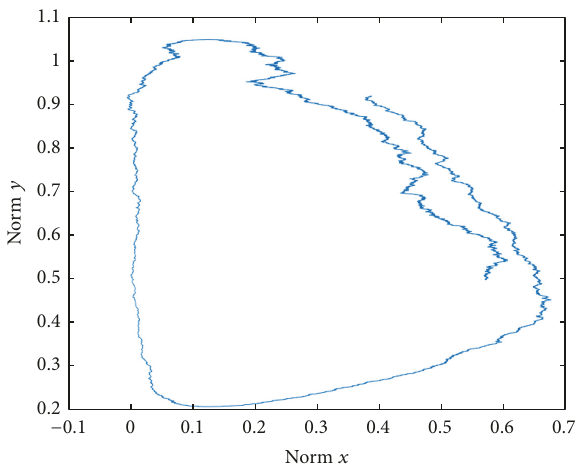
Figure9:Phasetrajectory {𝑥(𝑡)+√𝜀𝑋(𝑡),𝑦(𝑡)+√𝜀𝑌(𝑡), 𝑡 ∈ [0,20]} , 𝑚 = 1, 𝑟 = 1, 𝐴 = 0.5, 𝐾 = 1, 𝛾 = 1 , and 𝛿 = 0.2 . 𝑥(0) = 0.57 , and 𝑦(0) = 0.5